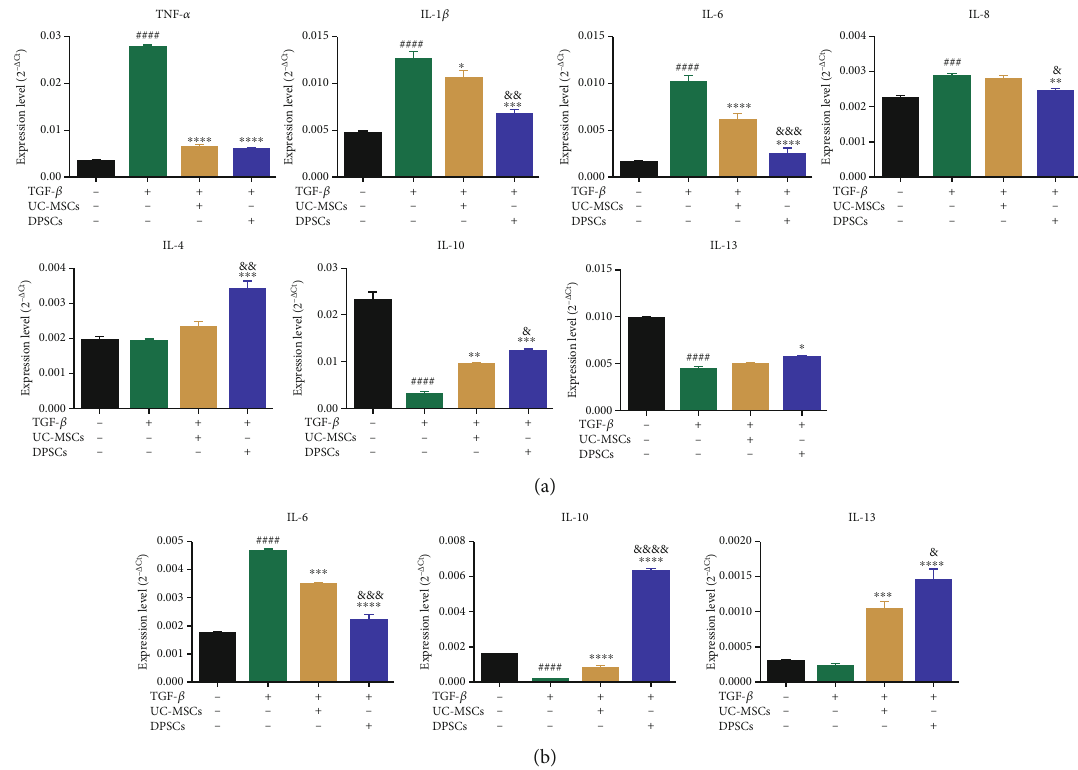
Figure 2: DPSCs alleviate the in fl ammatory responses of BEAS-2B and MRC-5 cells better than UC-MSCs. (a) The expression of in fl ammatory cytokines, including TNF- α , IL-1 β , IL-6, IL-8, IL-4, IL-10, and IL-13, in BEAS-2B cells was evaluated by qPCR. (b) The expression of in fl ammatory cytokines, including IL-6, IL-10, and IL-13, in MRC-5 cells was measured by qPCR. Each experiment was performed in triplicate. The data are shown as the means ± SEM . ANOVA followed by Tukey ’ s multiple comparisons test was used to evaluate these data. ### P < 0 : 001 and #### P < 0 : 0001 vs. Con; ∗ P < 0 : 05 , ∗∗ P < 0 : 01 , ∗∗∗ P < 0 : 001 , and ∗∗∗∗ P < 0 : 0001 vs. the TGF- β group; & P < 0 : 05 , && P < 0 : 01 , &&& P < 0 : 001 , and &&&& P < 0 : 0001 vs. UC-MSCs. Con: control; UC-MSCs: umbilical cord mesenchymal stem cells; DPSCs: dental pulp mesenchymal stem